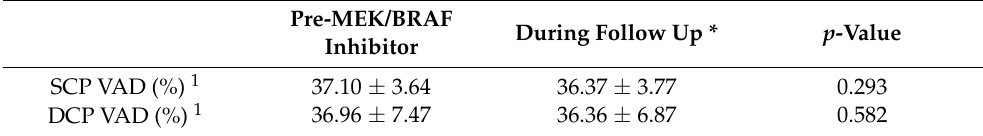
Table 2. Choriocapillaris flow void parameters at each control.